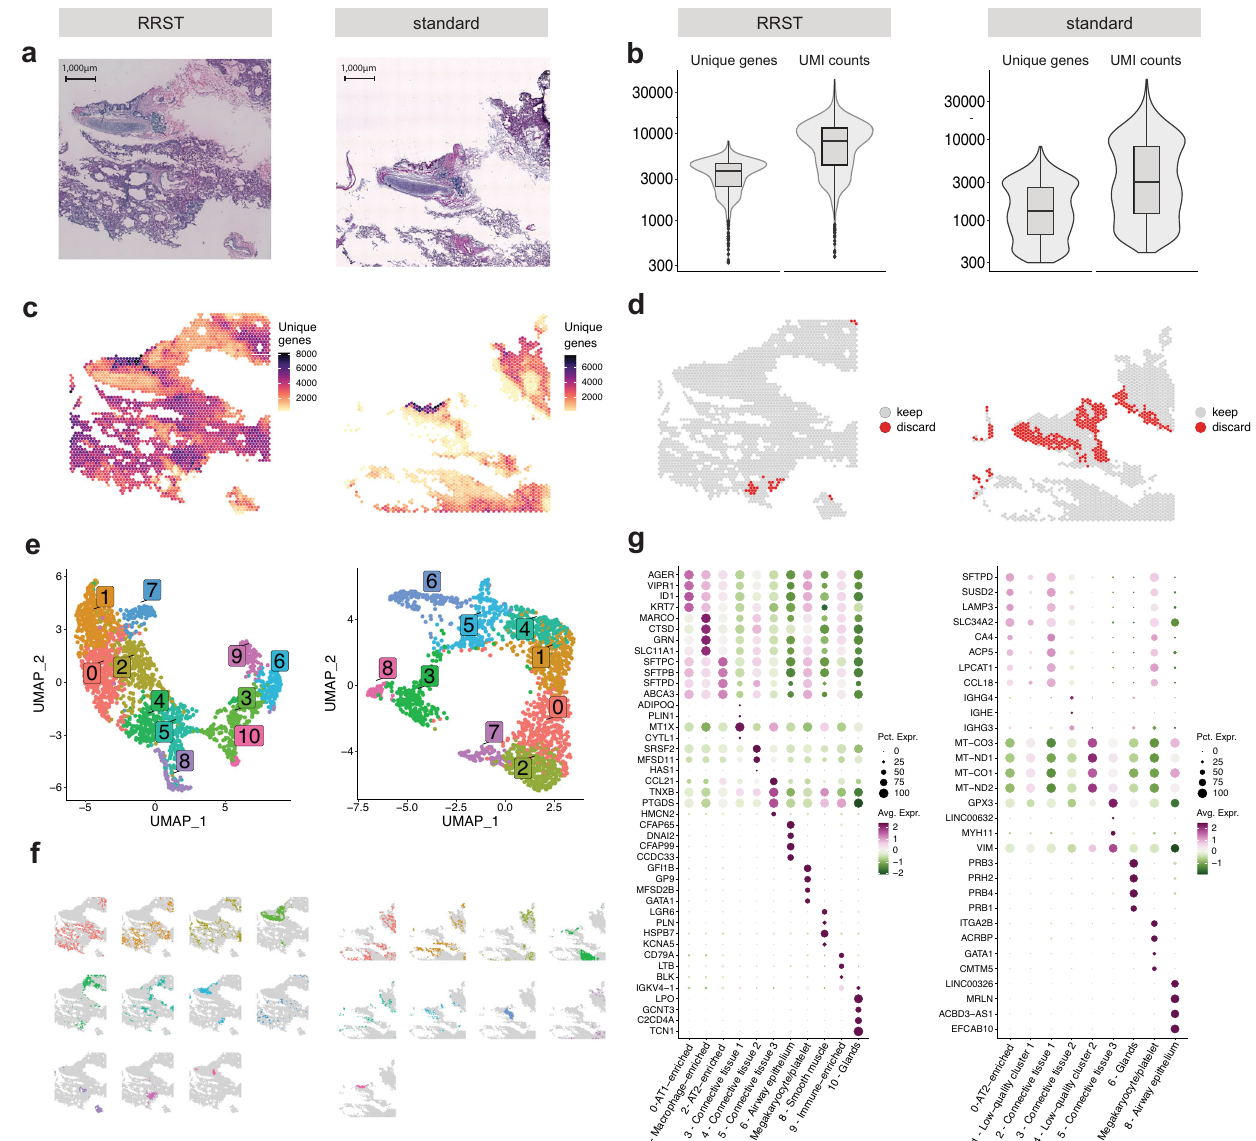
Fig. 2 | RRST and standard Visium applied to human adult lung tissue. Each subplot shows the RRST data on the left side and the standard Visium data on the right side. a H&E images of two representative tissue sections collected from the same tissue block. b Violin/boxplotsshowingthe distributionofunique genesand UMI counts for RRST ( n =1) and standard Visium ( n =2) data generated from consecutivetissuesectionsfromthesamelungtissuespecimen.The y -axisisshown inlog10scale.Boxplotsarepresentedasmedianvalueswherethelowerandupper bounds are the 25th and 75th percentiles. The upper and lower limits of the box- plots are de fi ned by the closest value no further than 1.5*IQR (inter-quartile range)